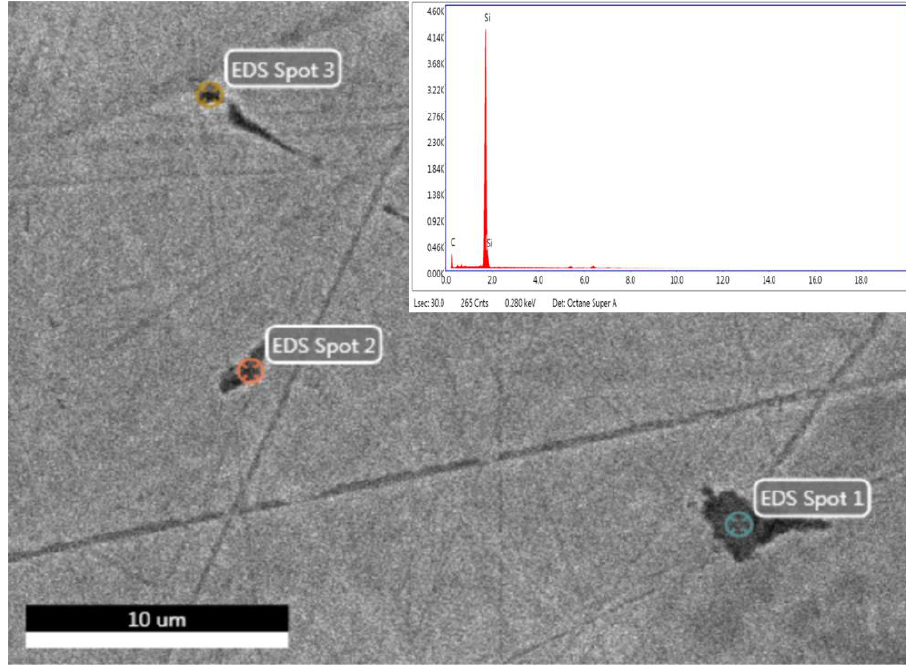
Figure A12. Evidence of Si-based inclusions, these inclusions have sharp points and could be crack initiators.